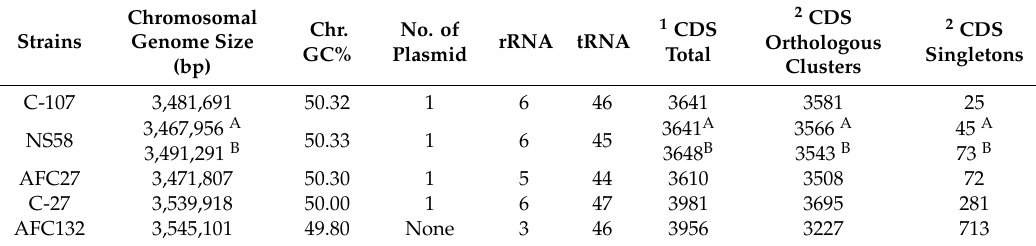
Table 1. General genome characteristics of Nitrosococcus oceani